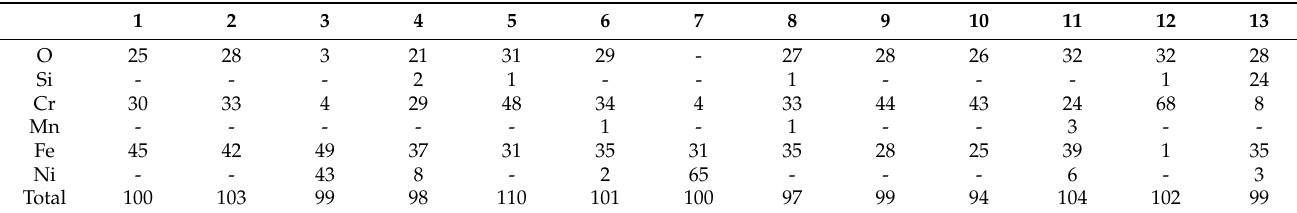
Table 5. EDS point analyses corresponding to Figure 14, in wt. %. No value indicated means the element was not detected at the analysis